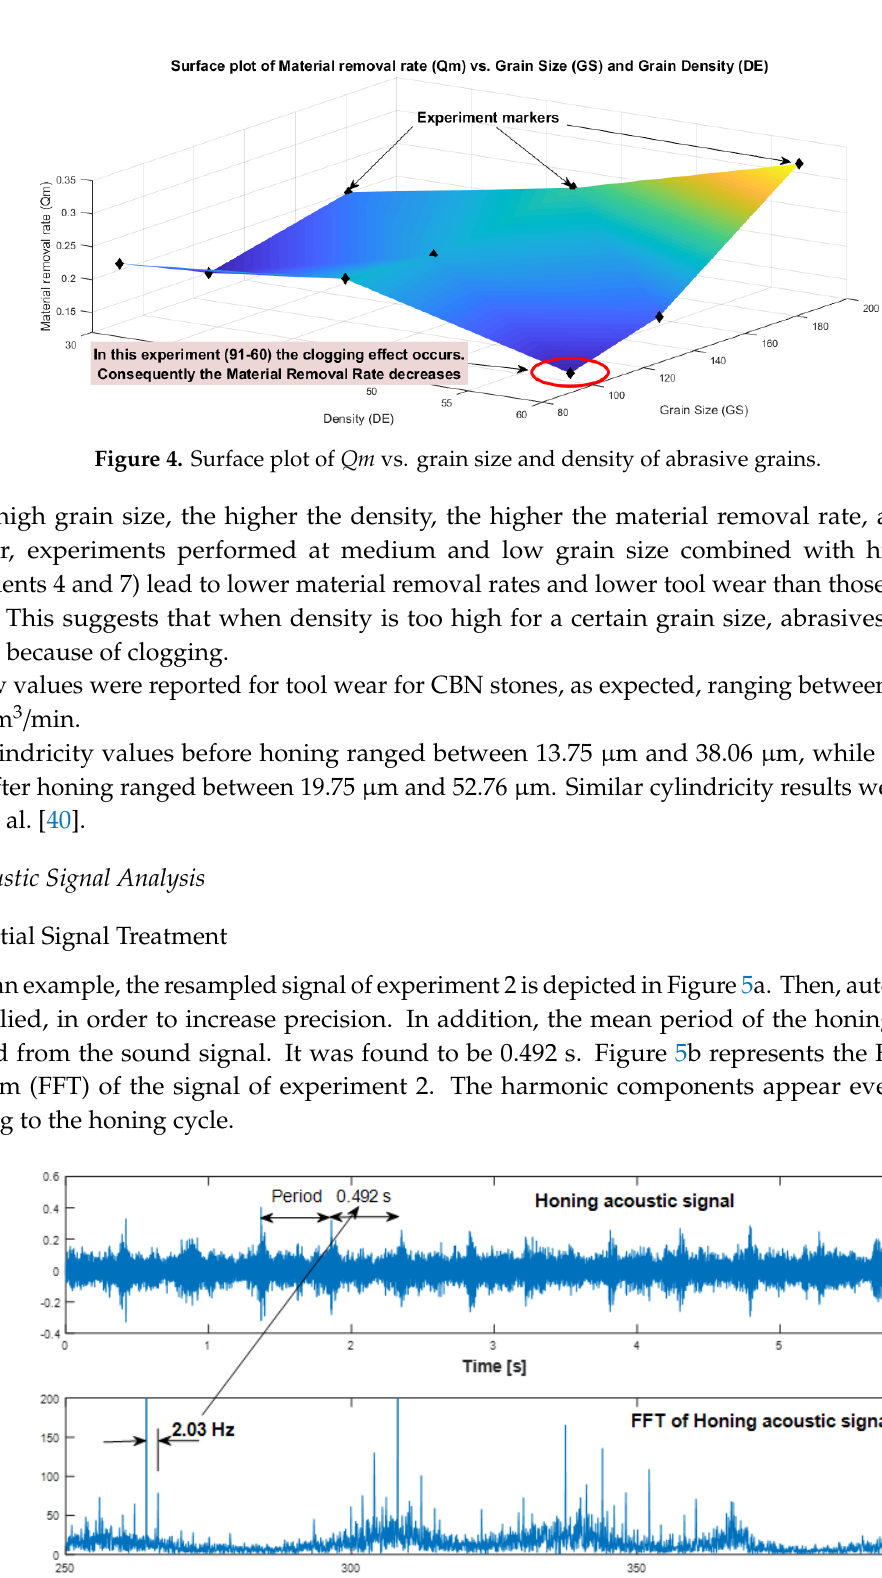
Figure 6. Signals of experiment 2: ( a ) Auto cross-correlation of the signal and ( b ) Fast Fourier transform (FFT) of the auto-cross correlation. 3.3.2. Application of a homomorphous filter The second step treatment of the signal involves cutting a certain length corresponding to several honing cycles. After this, the signal is decomposed into harmonic and non-harmonic parts, by means of a homomorphous filter. Figure 7 represents a signal containing three consecutive honing cycles. For frequencies between 130 and 18 Hz. Harmonic components are represented in red color, while non-harmonic components are highlighted in blue.